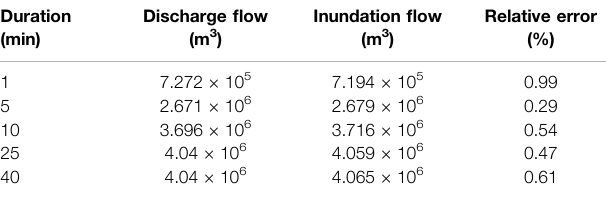
TABLE 3 | Analysis of water